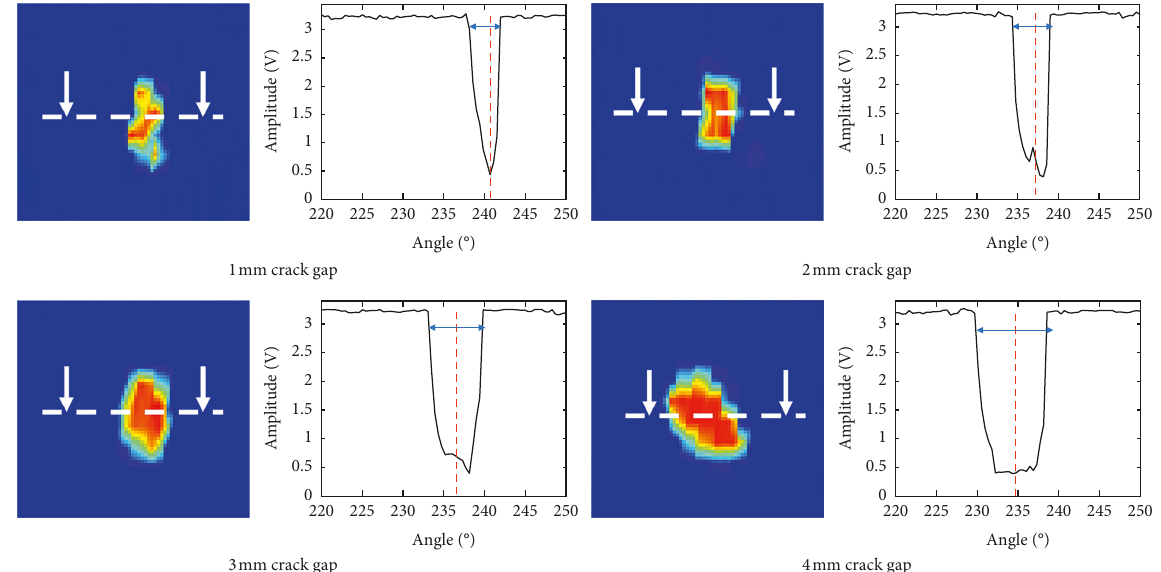
Figure 16: Inspection results for 7mm H-double type crack: C-scan (left) and cross section amplitude